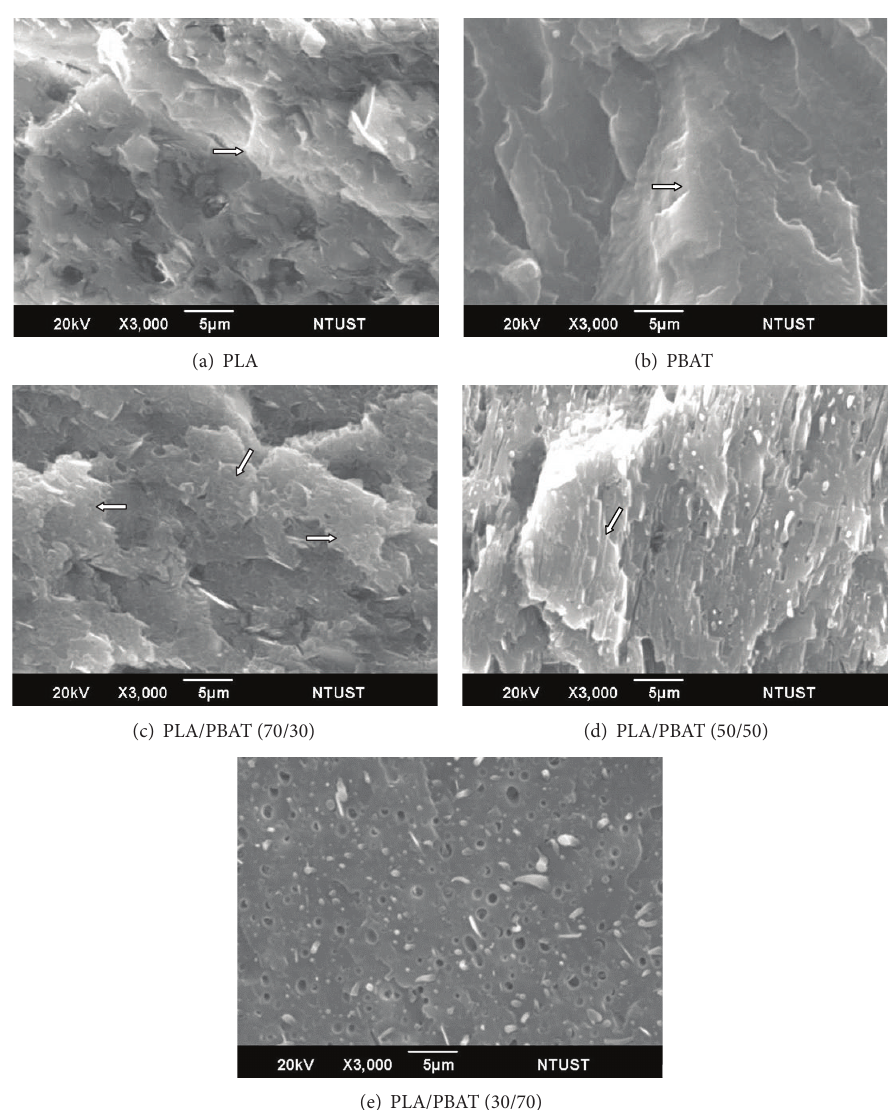
Figure 7: SEM graphs of break cross-section under the quenched break of liquid nitrogen. The white arrows in (a–d) point to the break